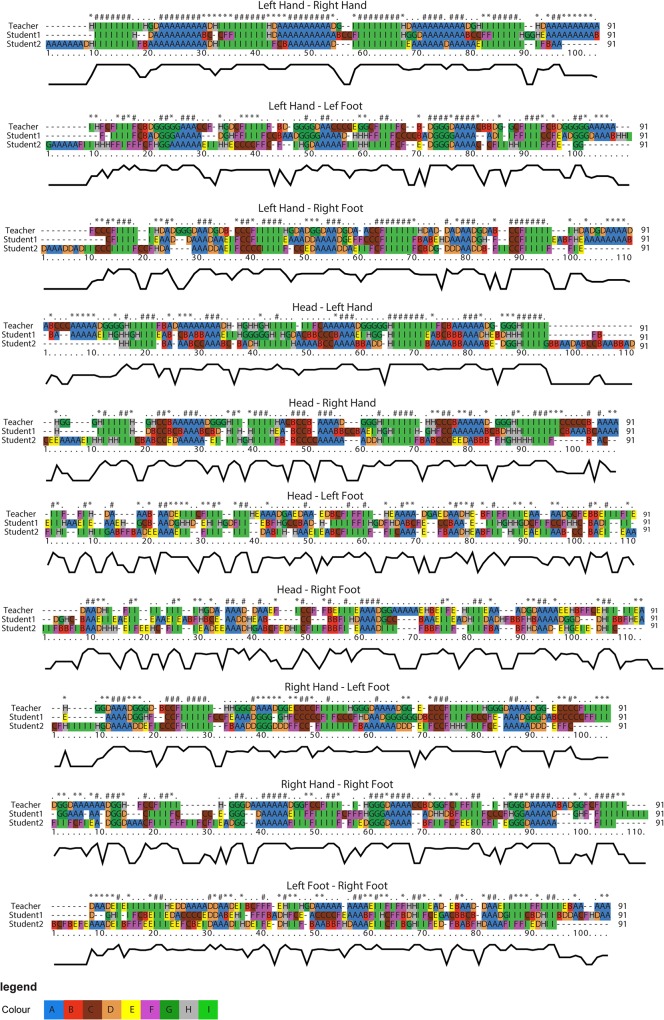
Multiple alignment of QTCB movement sequences of dancers’ body movements.